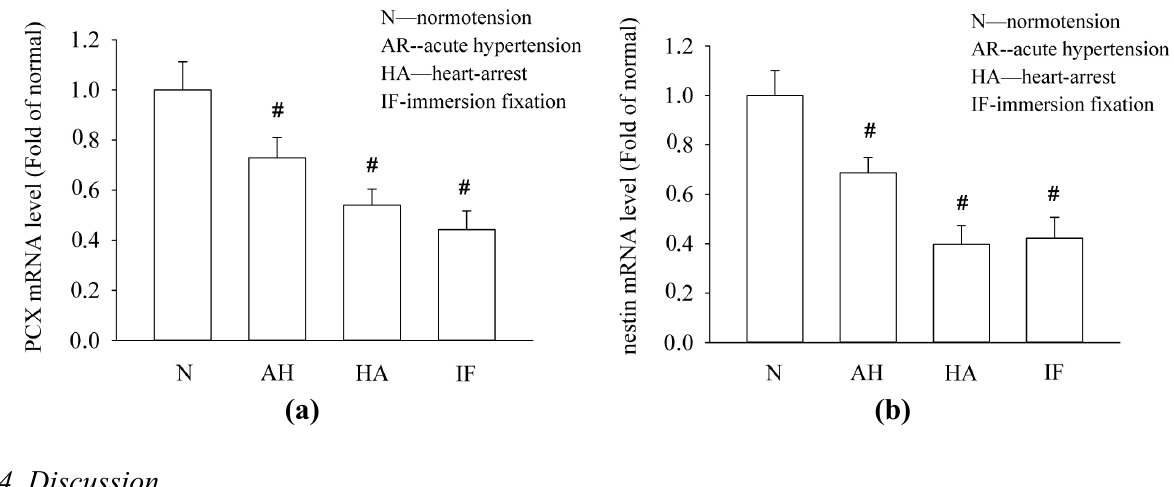
Figure 5. The effects of various hemodynamic conditions on the mRNA levels of PCX and nestin in kidney tissues. The mRNA levels of PCX and nestin in the kidney tissues under normotensive condition were prepared by the immersion-fixation method were also shown. The mRNA from kidney tissues was subjected to real-time quantitative PCR assays for PCX and nestin. The results are expressed as induction relative to the normotensive condition (mean ± SE), # p <